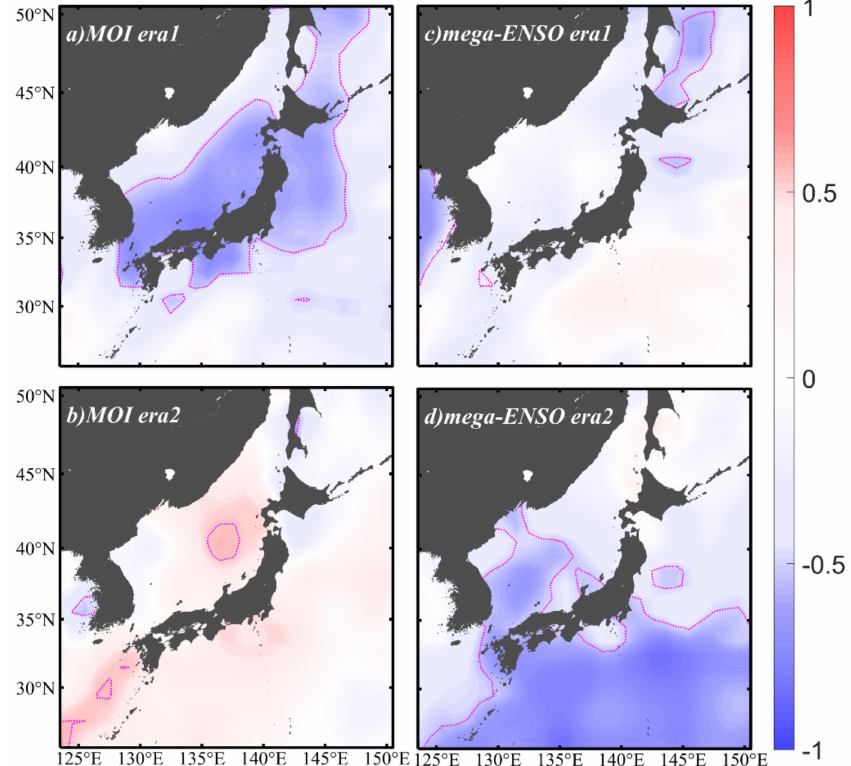
Figure 7. Nonstationary spatial relationships between MOI or mega-ENSO and the winter SST fields: maps of era-specific correlation coefficients between MOI or mega-ENSO and the winter SST fields ( a – d ). Purple dotted lines enclose areas with significant correlations ( p <